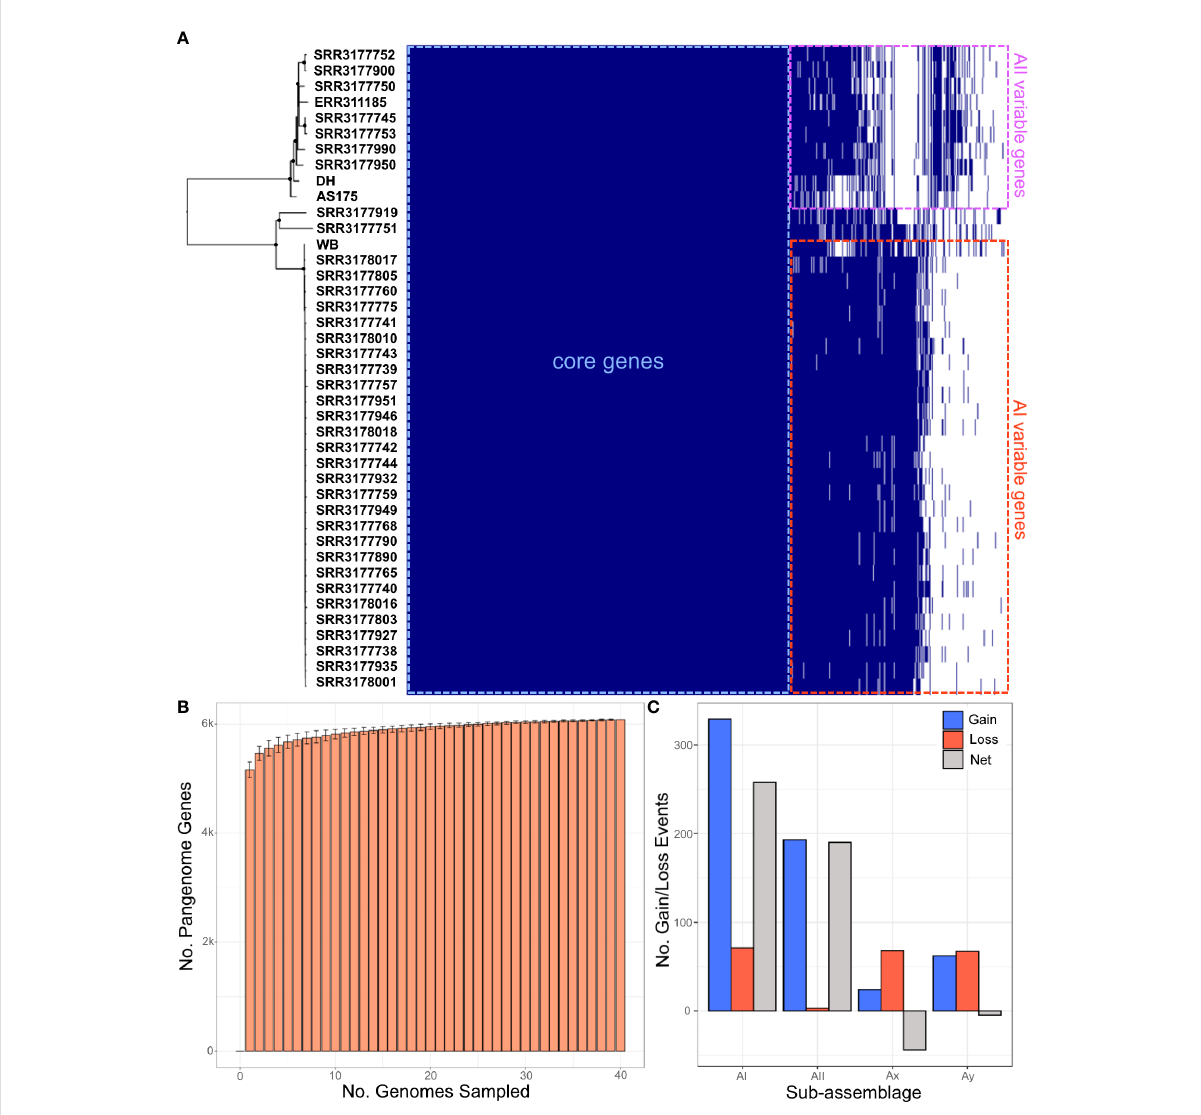
FIGURE 3 Characterization of the assemblage A pangenome. ( A , left side) Neighbor-joining tree estimated from SNP distances between genomes. Filled circles indicates nodes with ≥ 95% bootstrap support. ( A , right side) phyletic matrix of the assemblage A pangenome. Cells shaded in dark blue indicate a gene is present, and white-shaded cells indicate gene absence. (B) Rarefaction curve estimated from the phyletic matrix shown in (A) with 100 permutations. (C) Dynamics of gene gain/loss between sub-assemblages estimated by GLOOME. Blue bars indicate gene gain events, red bars indicate gene loss, and gray bars indicate net (gain – loss)